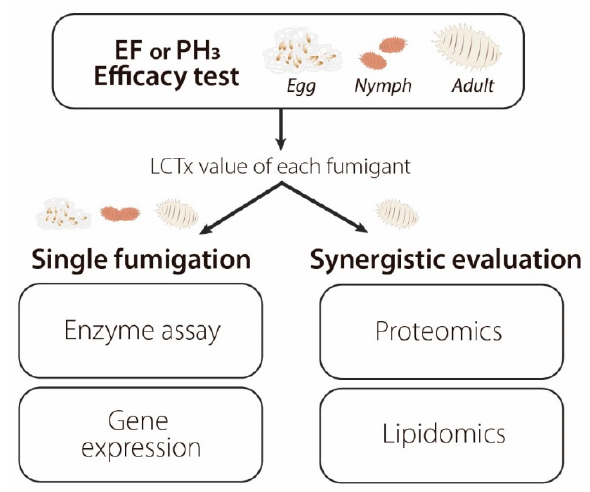
Figure 1. A graphical scheme of the study approach.